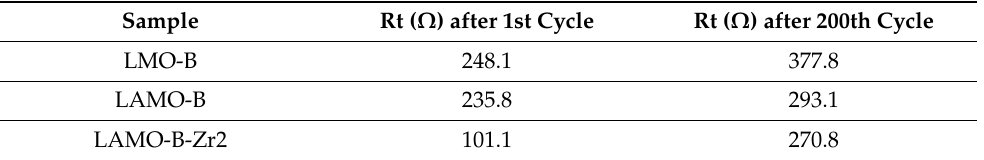
Table 3. The fitting results of the LMO-B, LAMO-B, and LAMO-B-Zr2 cells after the 1st and 200th cycle.